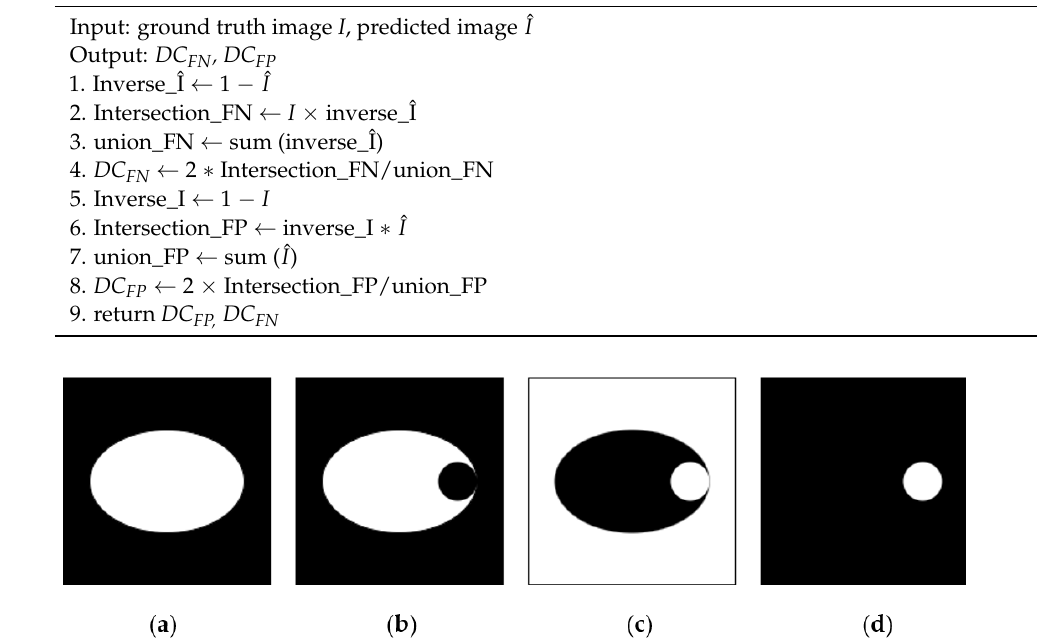
Figure 5. Binary maps of: ( a ) the ground truth, ( b ) the predicted output, ( c ) the inverted predicted output, and ( d ) the false negative area obtained by multiplying ( a , c ).